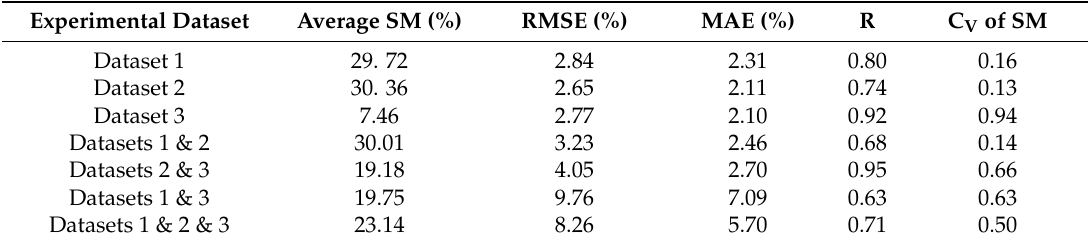
Table 3. The statistical relationship between measured and estimated soil moistures (SM). Experimental